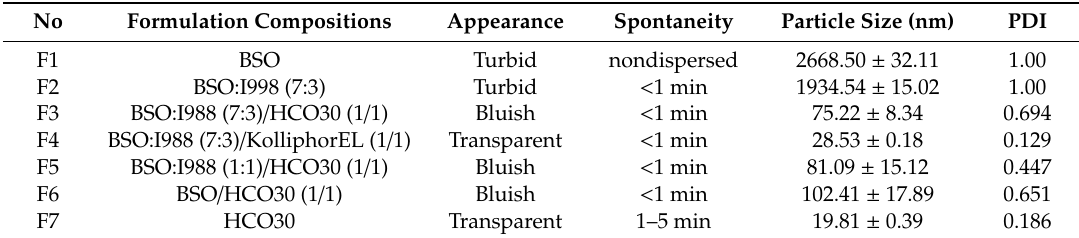
Table 1. The e ff ect of compositions on the appearance of various SNEDDS formulations prepared for CUR oral